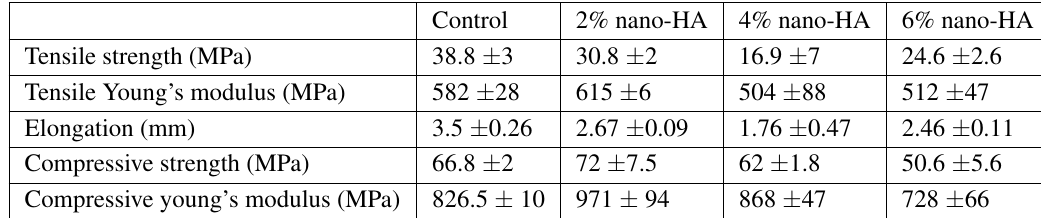
Table 1. Mechanical properties of PMMA/nano-HA compositions